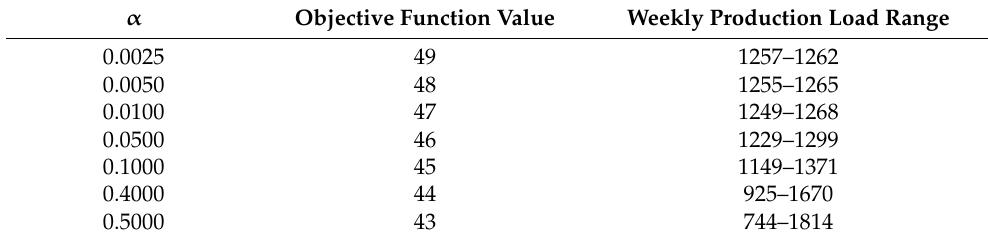
Table 6. Results of Case 1 at various values of α